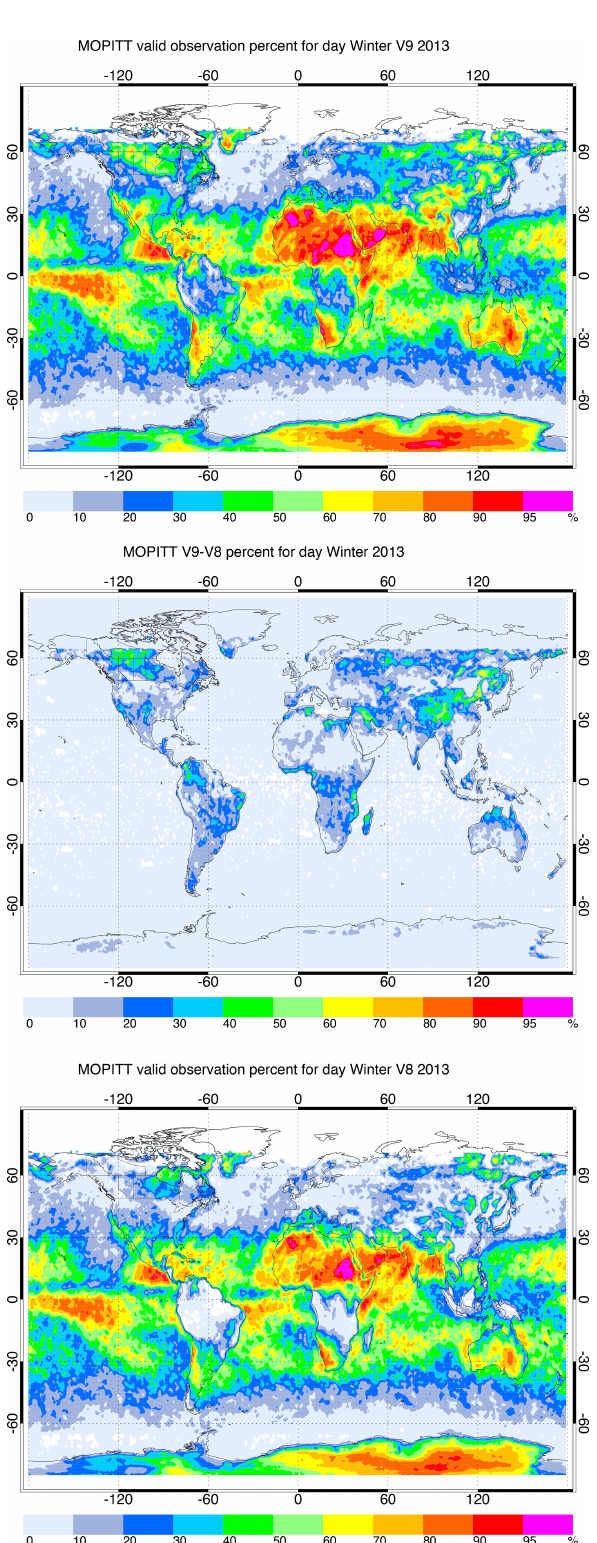
Figure 2. Seasonally averaged spatial distribution of the success- ful MOPITT retrievals in winter 2013 for V9 (top panel), V8 (bot- tom panel) and V9–V8 (middle panel). Data were aggregated into 1 ◦ × 1 ◦